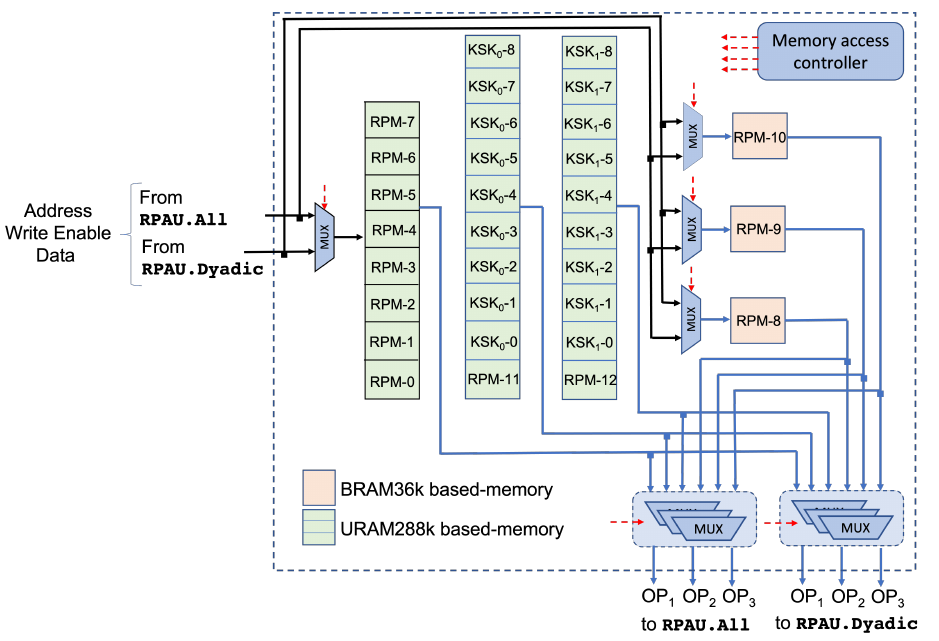
Figure 6: Organization of memory elements inside the memory bank. One memory bank is connected to a one core of the NTT unit. There are 16 such memory banks inside each RPAU. Any residue polynomial is split into 16 fragments, and one fragment is stored in one RPM- i of a memory